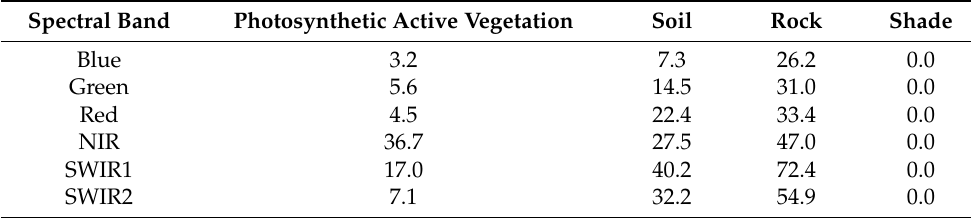
Table 3. Endmember set derived from [42]; values are in percentage reflectance. Spectral Band Photosynthetic Active Vegetation Soil Rock Shade Blue 3.2 7.3 26.2 0.0 Green